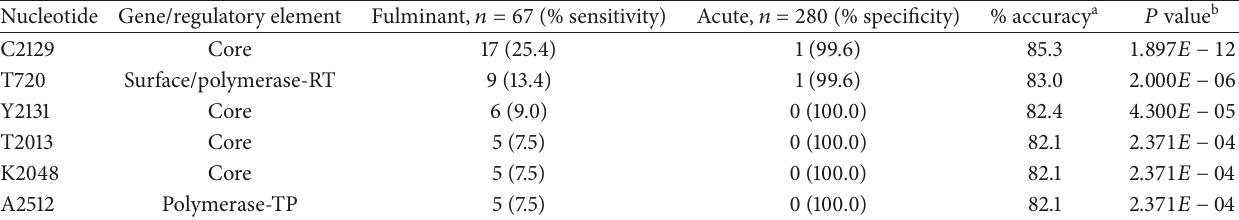
Table 2: The best combination of six candidate nucleotides of HBV associated with fulminant hepatitis was chosen from top 55 candidate nucleotides using brute force selection method implemented with SVM dot kernel algorithm.